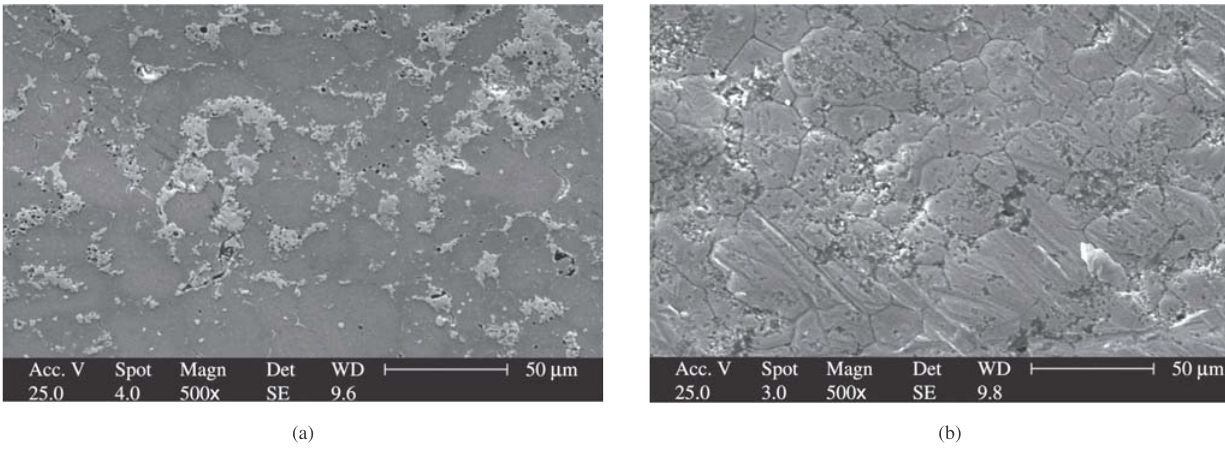
Figure 3. Scanning electron micrographs of electrode 7: a) before; b) after potentiostatic ageing.